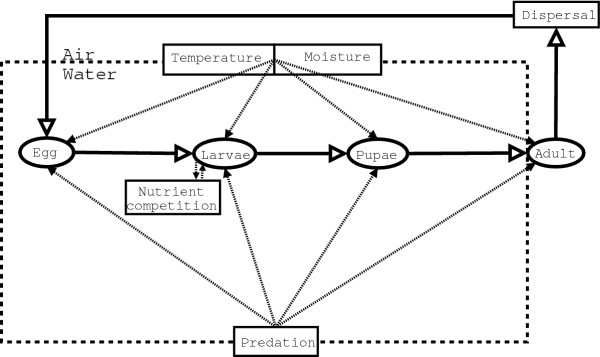
Model description.